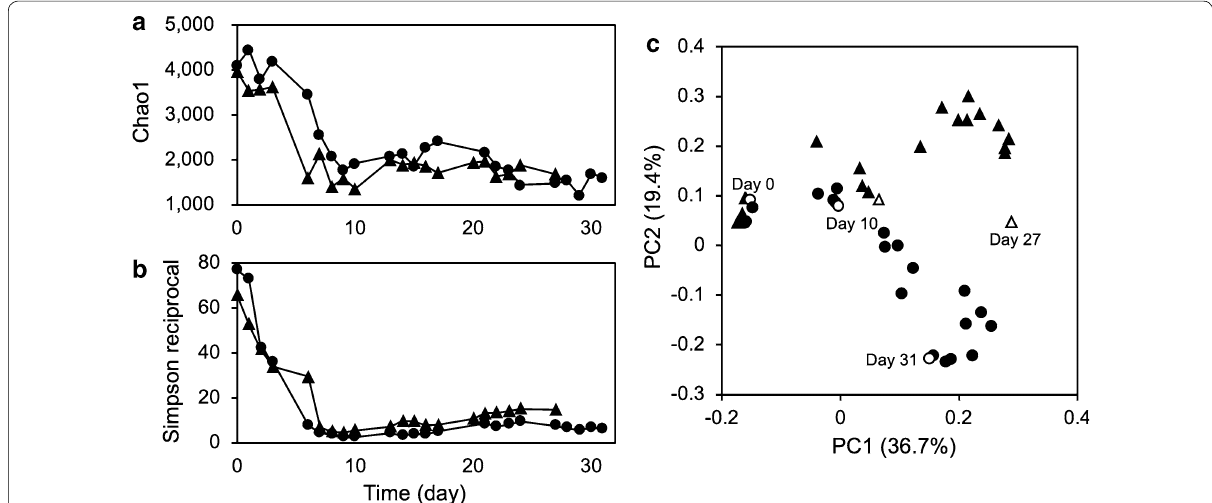
Fig. 2 Alpha‑diversity indices and the PCoA plot based on the sequence data. a Chao1; b simpson reciprocal. Each index was calculated based on an equal amount of sequences (19,218 and 14,598 for Reactors 1 and 2, respectively) that were sub‑sampled from the original libraries 10 times. For each index, a higher value represents a more diverse microbial community. c PCoA scatter plot of 16S rRNA sequences based on the weighted UniFrac distances. Circles and triangles denote Reactors 1 and 2,